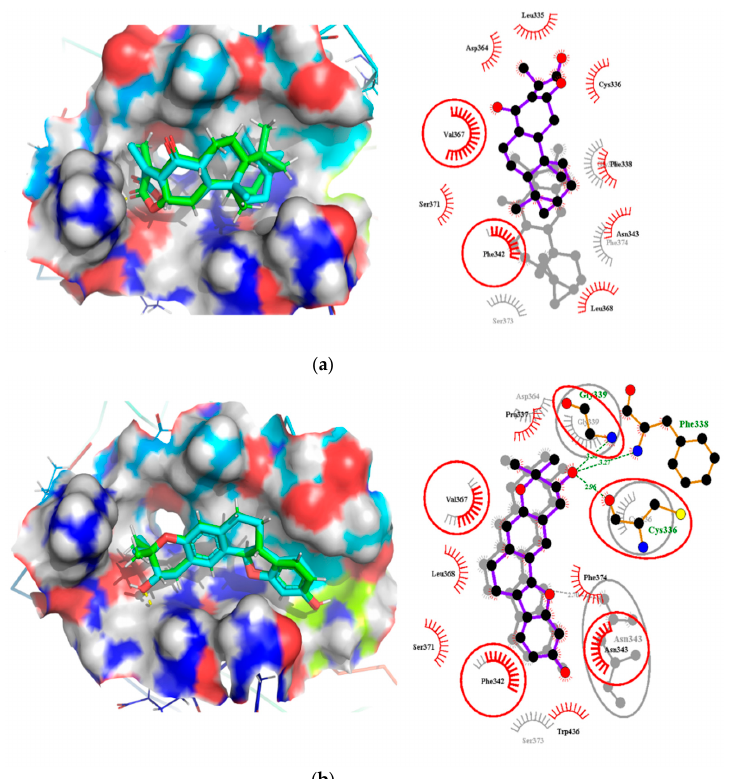
Figure 8. Binding mode characterization using superimposition and LigPlot+ analyses. ( a ) The pre- and post-100 ns MD simulations of RBD-NANPDB2403, and ( b ) RBD-ZINC95486008 complexes. Ligands for the pre- and post-MD simulations are shown in green and cyan colors, respectively. The overlapped interactions between the pre- and post-MD simulations are circled in red color.